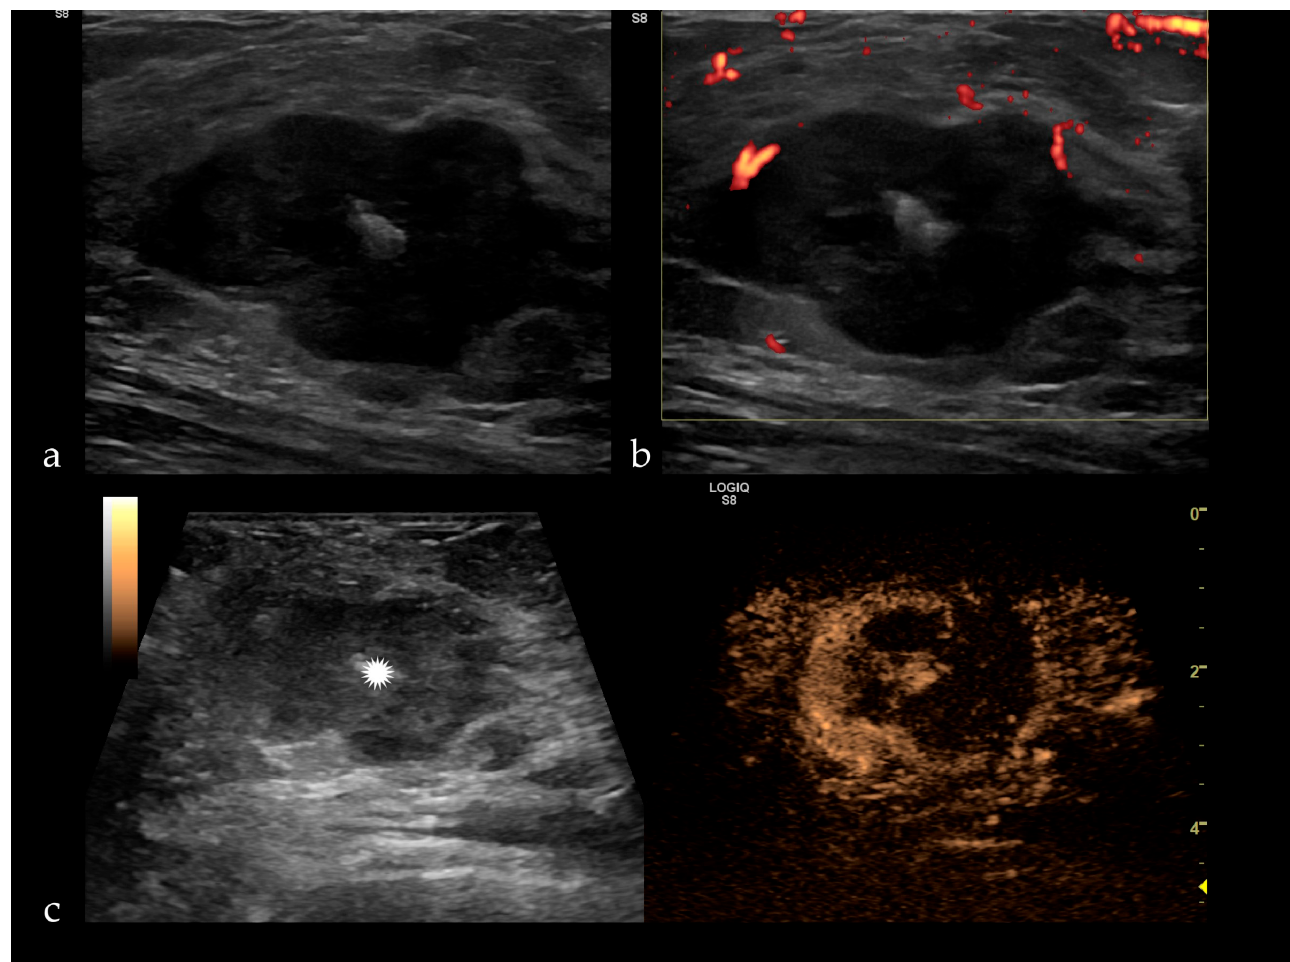
Figure 3. ( a ) Triple negative breast cancer appears as a hypoechoic, irregular mass, with a central hyperechogenity represented by a clip (white star), peripheral vascularization on Doppler ultrasound ( b ), inhomogeneous enhancement and filling defects after SonoVue administration ( c ).